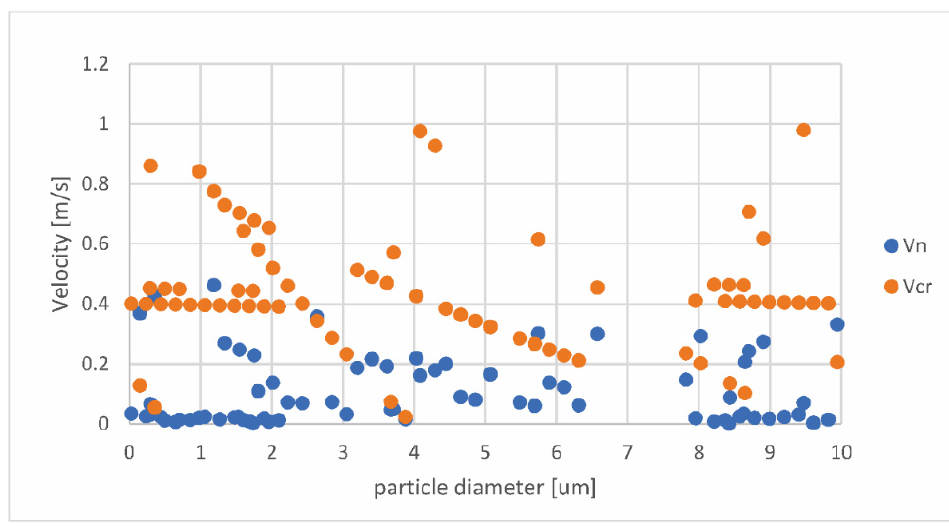
Figure 12. Dependence of critical ( v cr ) and normal ( v n ) velocities on the particle diameters.